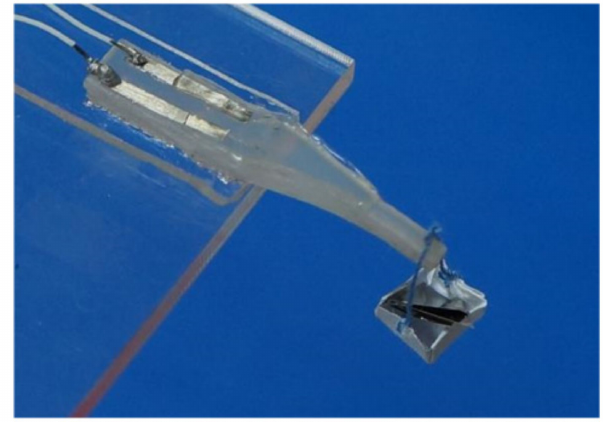
Figure 8. Photo of the force applied to the tactile